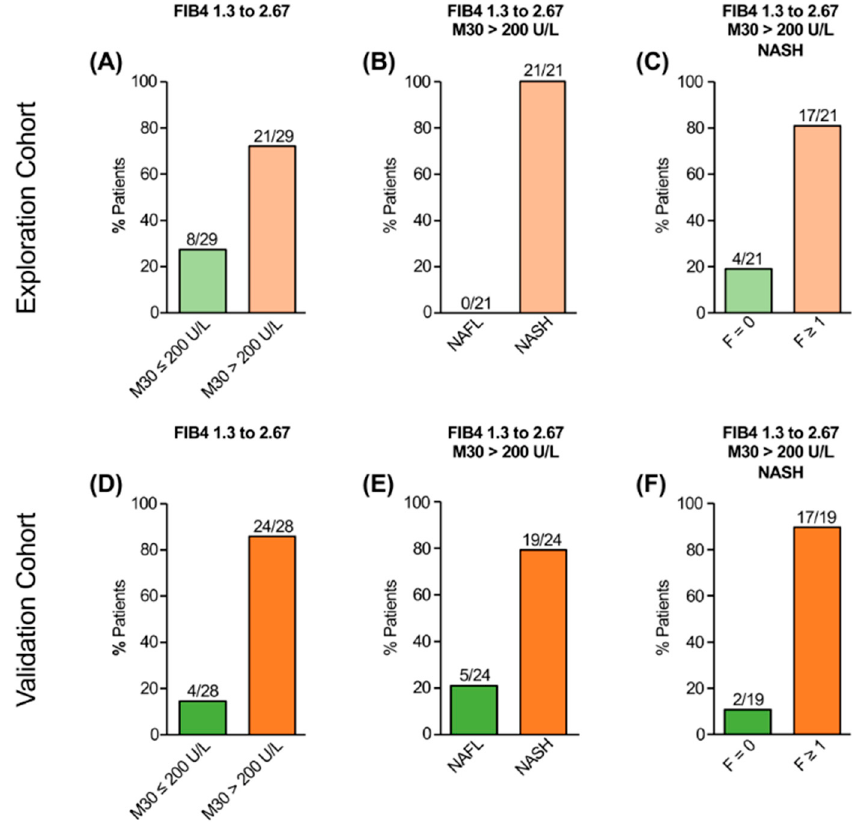
Figure 3. Serological detection of M30 levels in NAFLD patients with intermediate FIB-4 (1.3–2.67). In the exploration cohort, NAFLD patients with intermediate FIB-4 had elevated M30 levels in the majority of cases ( A ). All patients with elevated M30 levels showed NASH ( B ) and the majority of them revealed fibrosis ( C ). Most NAFLD patients with intermediate FIB-4 in the validation cohort showed elevated M30 levels ( D ) and the majority of them revealed NASH ( E ), mostly with fibrosis ( F ).